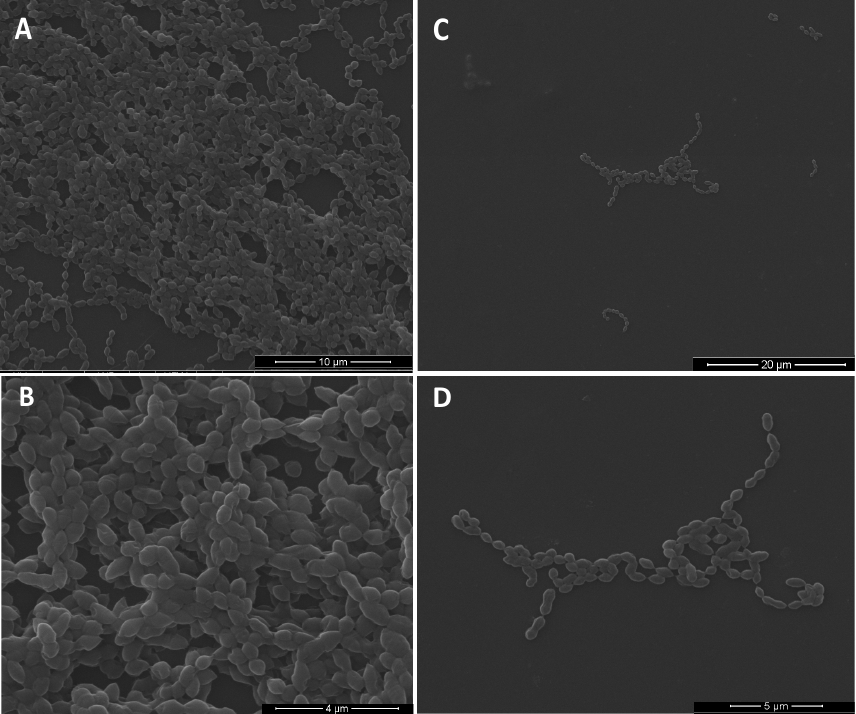
Figure 6. Scanning electron microscopy of S. mutans -LT11 surface adhesion to a polystyrene microwell plate. Without treatment at 7000× ( A ) and 19,000× ( B ); and treated with 100 µM of molecule ZI-187, at of 4000× ( C ) and 11,000× ( D ).